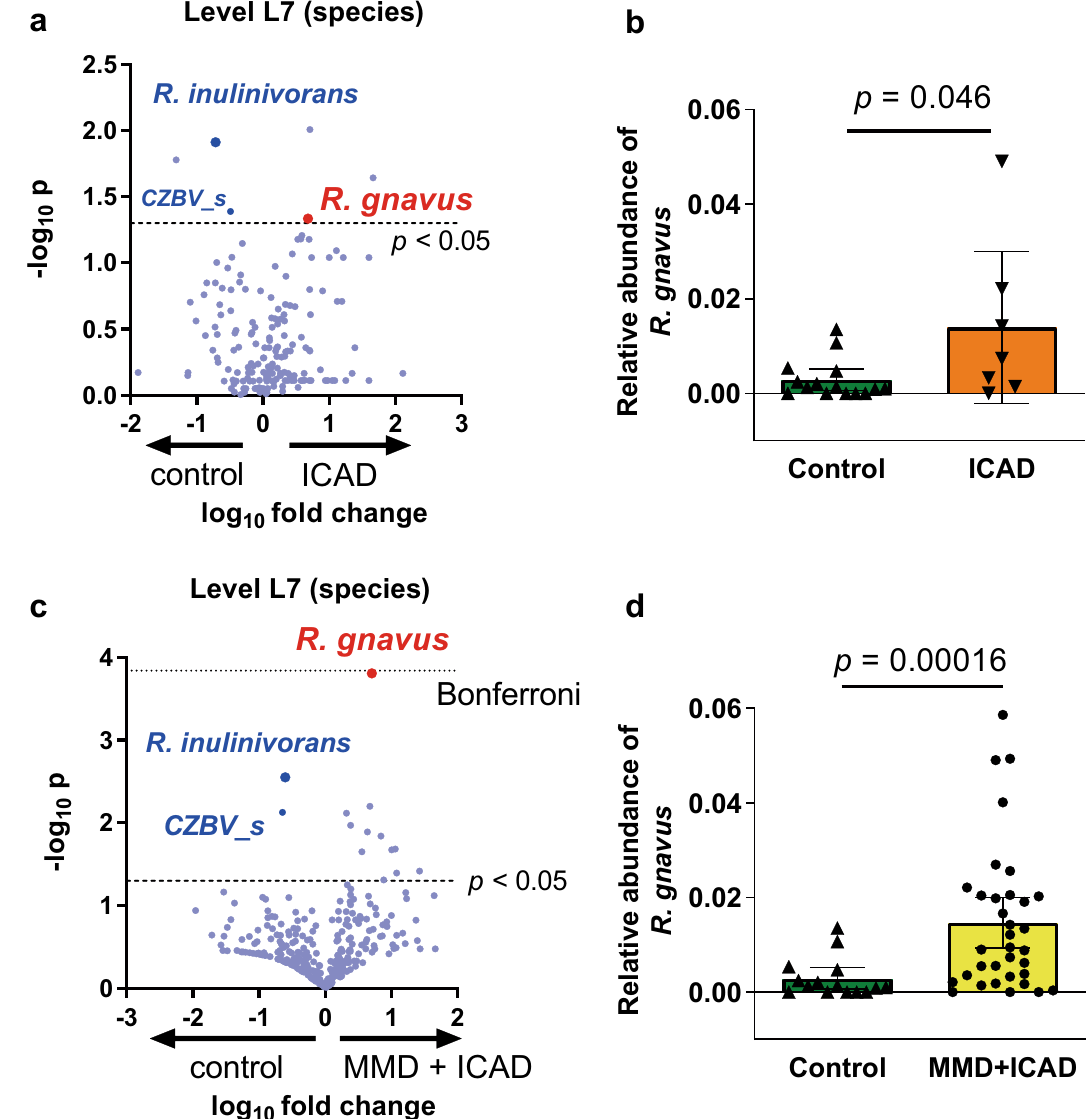
Figure 4. Association of R. gnavus with non-moyamoya intracranial large artery disease (ICAD). ( a ) The volcano plot showed R. gnavus was one of the top ranked microbes that was abundant in patients with ICAD as compared with controls. ( b ) Relative abundance of R. gnavus was significantly associated with ICAD ( P = 0.046). Bars and whiskers indicate means and standard deviations. ( c,d ) When combining patients with MMD and those with ICAD, the volcano plot shows that the relative abundance of R. gnavus was significantly higher in patients than controls, and the p value was close to the Bonferroni corrected threshold (fine dotted line). Decreased abundance of R. inulinivorans and CZBV_s was observed not only in MMD (Fig. 3a) but also in ICAD ( a ) or in cerebrovascular disease (MMD + ICAD) ( c